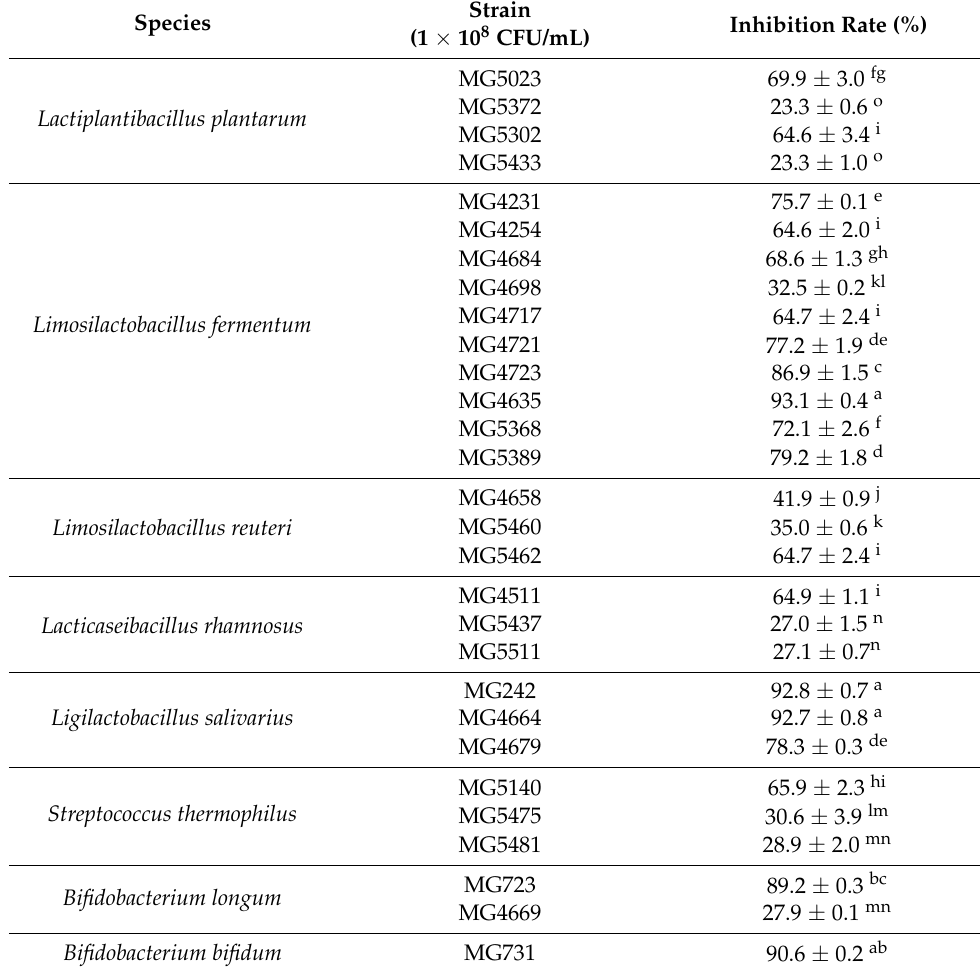
Table 3. Antioxidant activity of LAB based on ABTS + radical scavenging